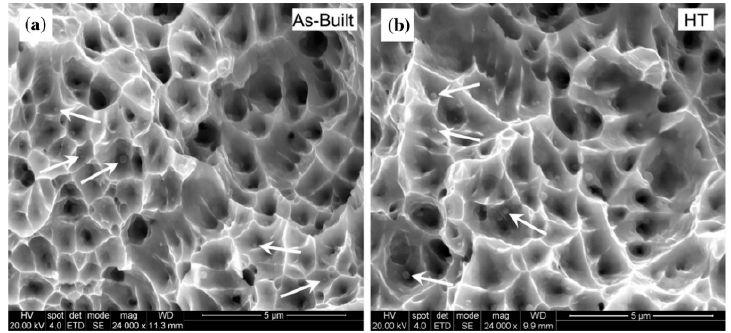
Figure 15. Fracture surfaces of AISI 316L stainless steel: ( a ) as-built and ( b ) heat-treated. Arrows mark